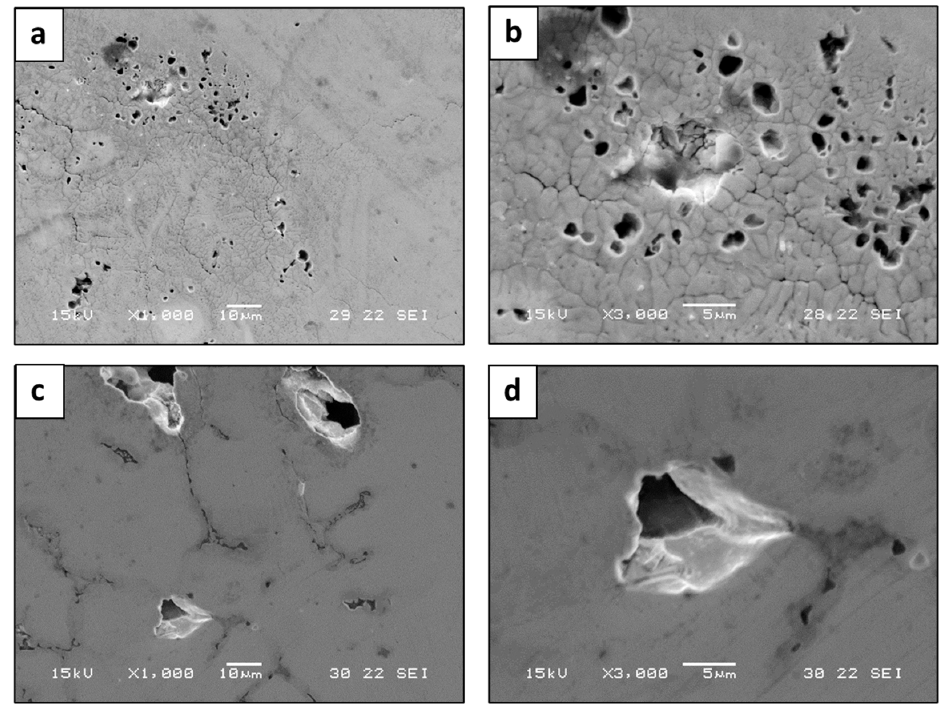
Figure 12. General appearance of localized corrosion attack: ( a , b ) HEA WTaMoNbV produced by LPBF process, ( c , d ) counterpart AMF alloy.